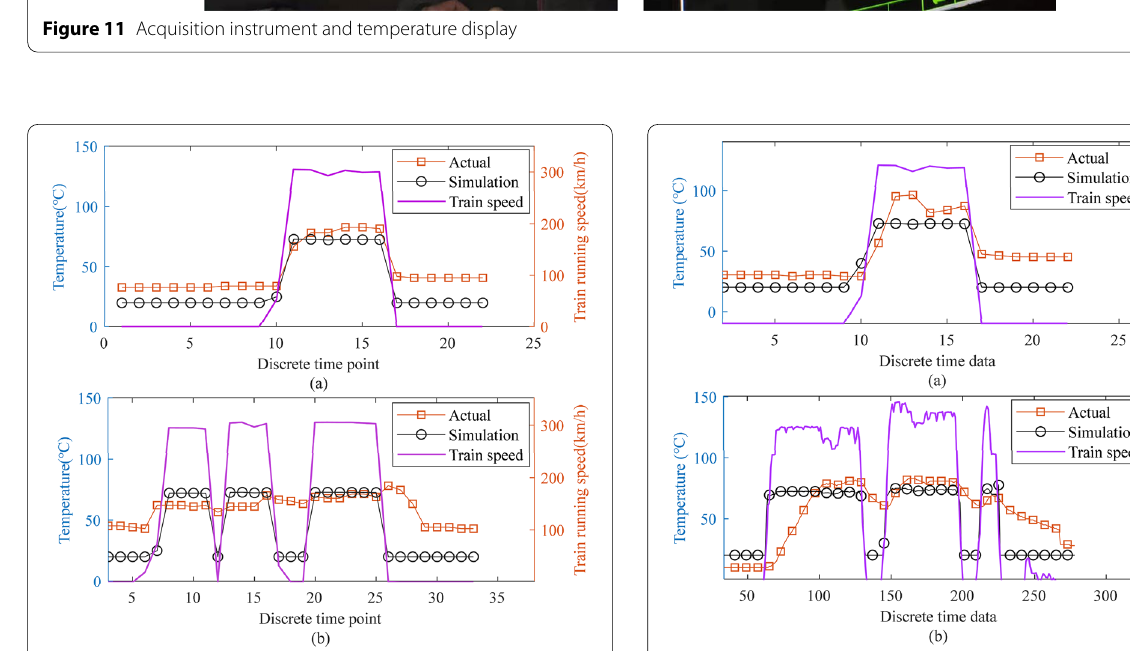
Figure 12 Comparative analysis of outer-ring temperature Figure 13 Comparative analysis of spindle